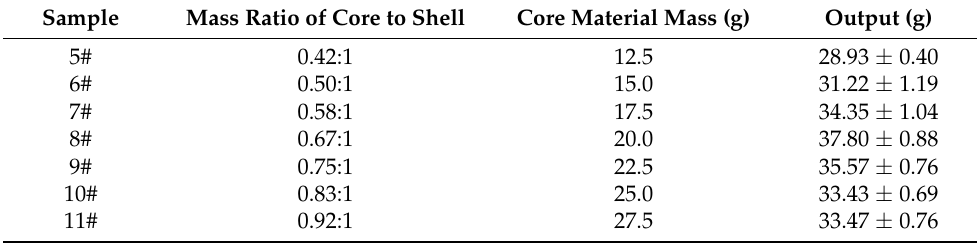
Table 8. Output results of microcapsules by the single factor test.